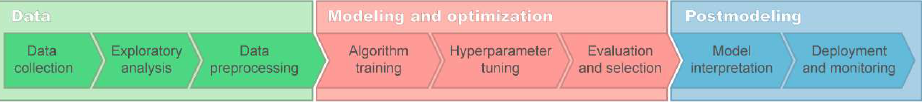
Table 3. Machine learning algorithms used.